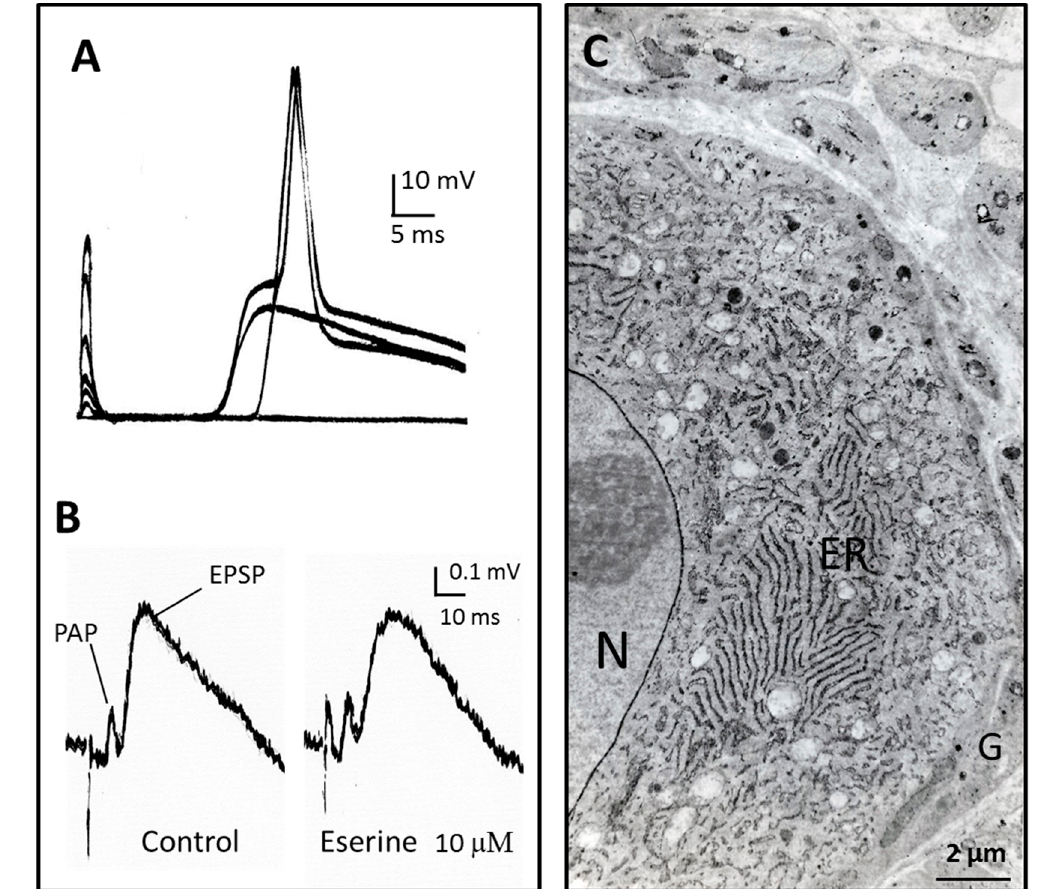
Figure 2. Intermediate time-course of transmission in the rat sympathetic ganglion. ( A ) Excitatory postsynaptic potentials and action potentials recorded intracellularly from a neurone of the rat superior cervical ganglion in response to stimuli of increasing intensity applied to the preganglionic nerve. The different delays after stimulus artefact result from different conduction times in the preganglionic nerve fibres. The initial nicotinic excitatory post synaptic potential (EPSP) lasts for several tens of ms; ( B ) Extracellular recording in a ganglion where transmission was partly blocked by mecamylamine (25 µM). PAP: presynaptic action potential [52]. At the difference of neuro-muscular and nerve-electroplaque junctions, the anticholinesterase eserine does not prolong the EPSP time course; ( C ) AChE localisation in the same preparation. Most of the activity is present in endoplasmic reticulum of neurons (ER) and on the nuclear membrane (N). Glial cells (G) do not show significant AChE histochemical reaction. Most of AChE in ganglia is present as the globular G4-AChE, which is secreted from the neurons. See further explanations and references in the text. Unpublished observations